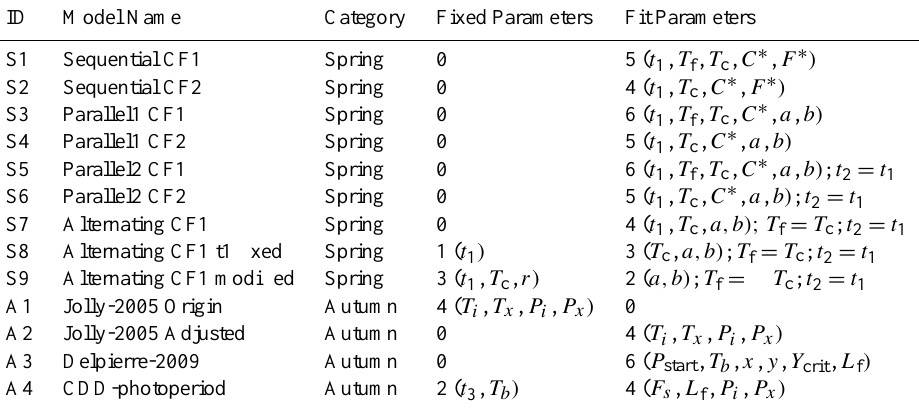
Table 5. Summary of phenology models with fit parameters calibrated against the long-term phenology at four US deciduous sites. The detailed parameters for the selected models, S9 and A4, are summarized in Table S3. Optimized parameters for other models are summarized in Table